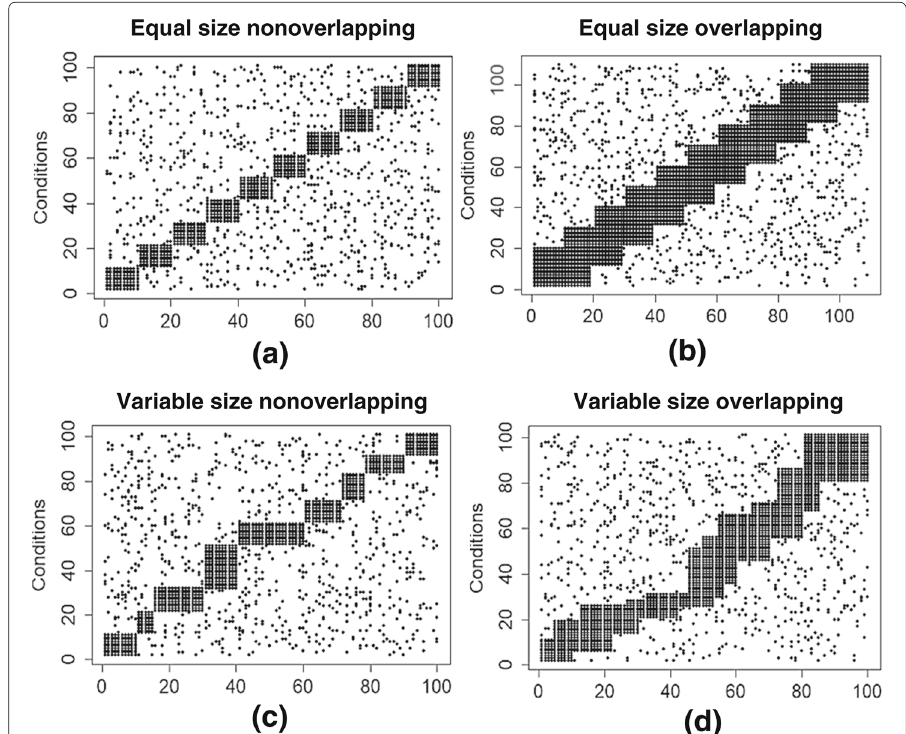
Fig. 4 Synthetic dataset with maximum noise